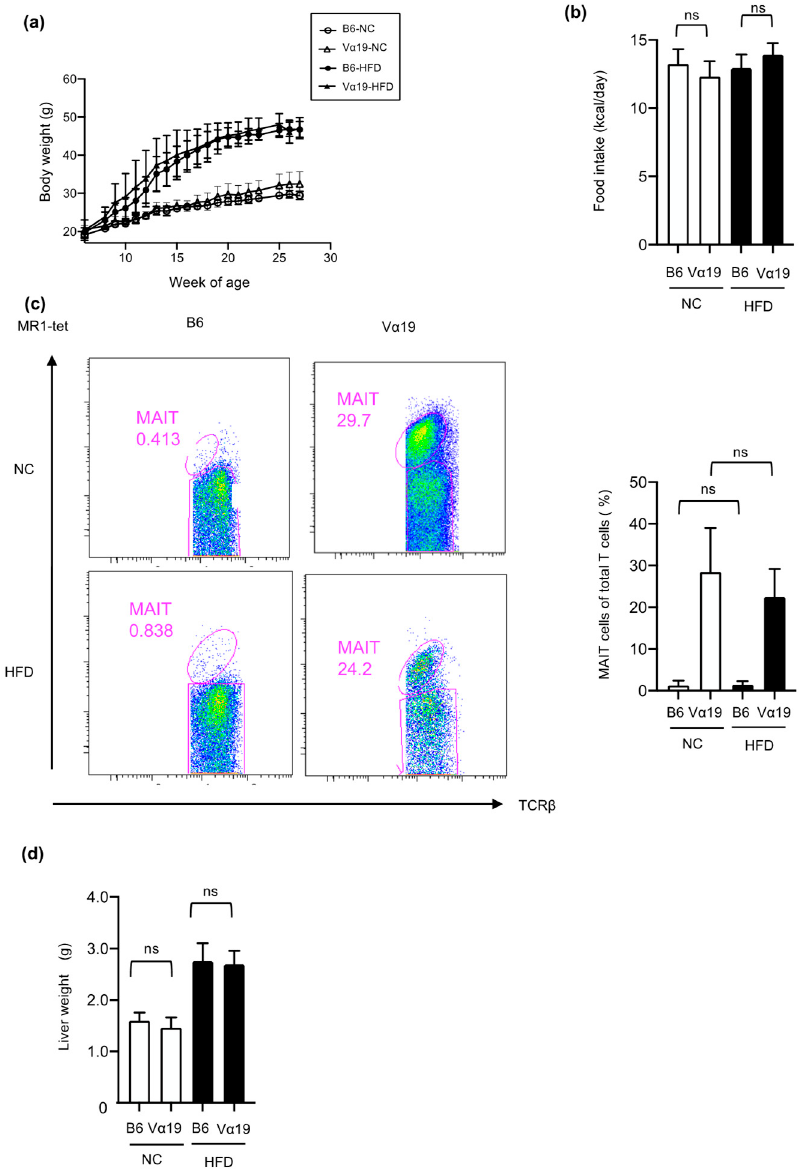
Figure 1. Body weight, food intake and liver weight were not different between V α 19 mice and C57BL/6 mice fed normal chow and a high-fat diet. ( a ) Development of body weight in V α 19 mice (V α 19) and C57BL/6 mice (B6). Open circles, B6 mice on normal chow (NC); open triangles, V α 19 mice on NC; closed circles, B6 mice on high-fat diet (HFD); closed triangles, V α 19 mice on HFD. ( b ) Food intake of V α 19 mice and B6 mice at age 24 to 27 weeks. ( c ) Flowcytometry analysis of liver cells from V α 19 and B6 mice fed NC and HFD. Cells in the fraction positive for both T cell receptor β and MR1-tetramer (MR1-tet) were defined as mucosal-associated invariant T (MAIT) cells. Representative results are shown. ( d ) Liver weight of V α 19 and B6 mice at 27 weeks of age. The results are shown as the mean ± SD for 6 to 12 mice per group. ns, not statistically